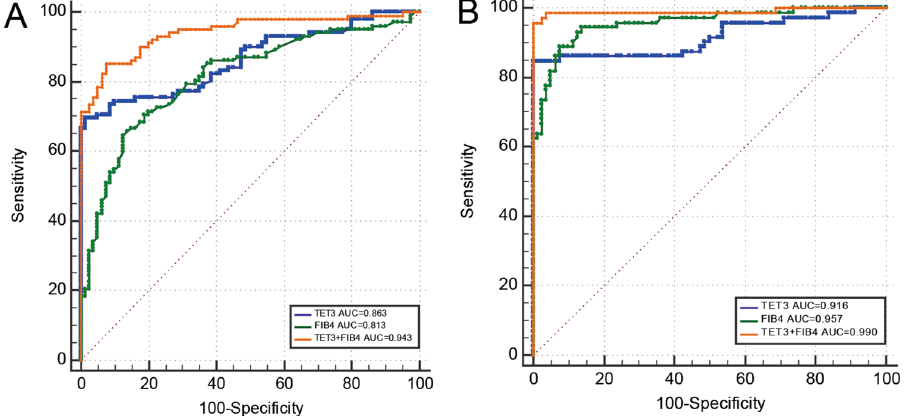
Figure 3. ROC analysis of serum TET3 and fibrosis and cirrhosis. ( A ) ROC curves for TET3, FIB-4 index, combination of TET3 and FIB-4 index for predicting Liver fibrosis; ( B ) ROC curve for TET3, FIB-4 index,